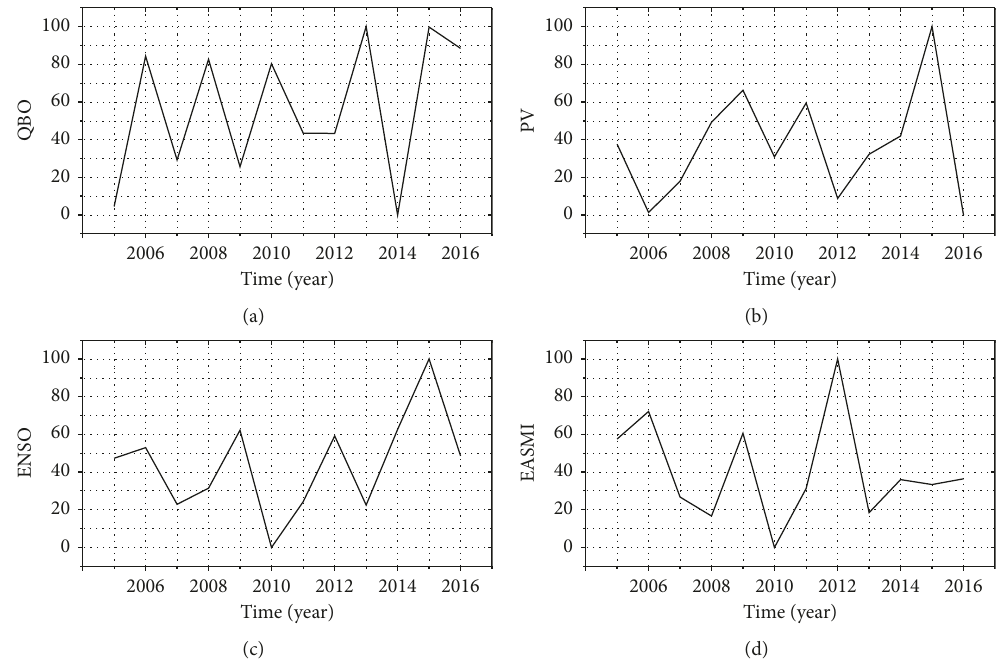
Figure 8: Annual normalized time series of (a) QBO, (b) PV, (c) ENSO, (d) and EASMI (black solid